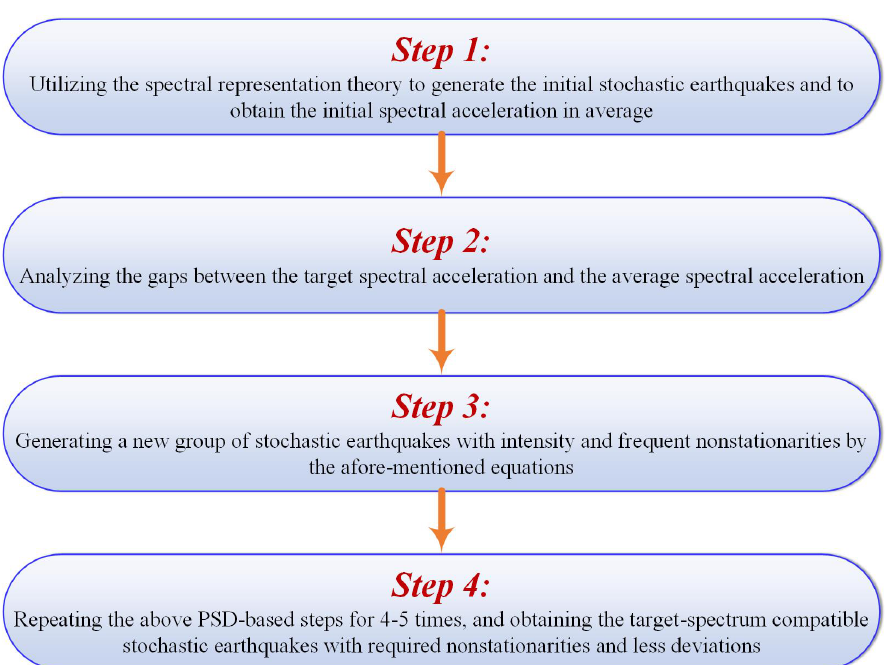
Figure 1. The flow diagram of the PSD-based iterative procedure of the stochastically generated nonstationary